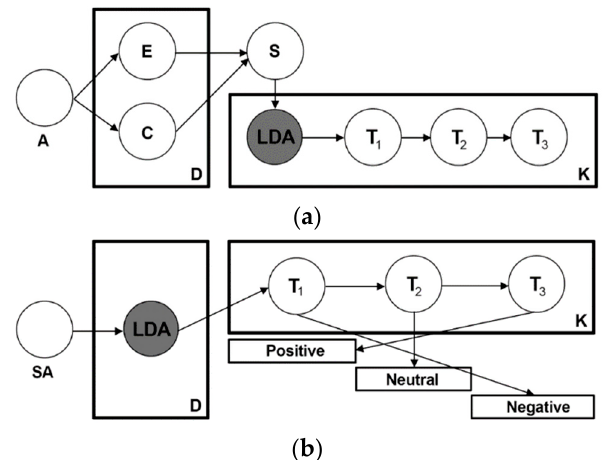
Figure 3. Sentiment analysis (SA) process from LDA to SA: ( a ) topics classification process; ( b ) sentiment analysis process applied to topics. Source: Saura and Bennett [3].